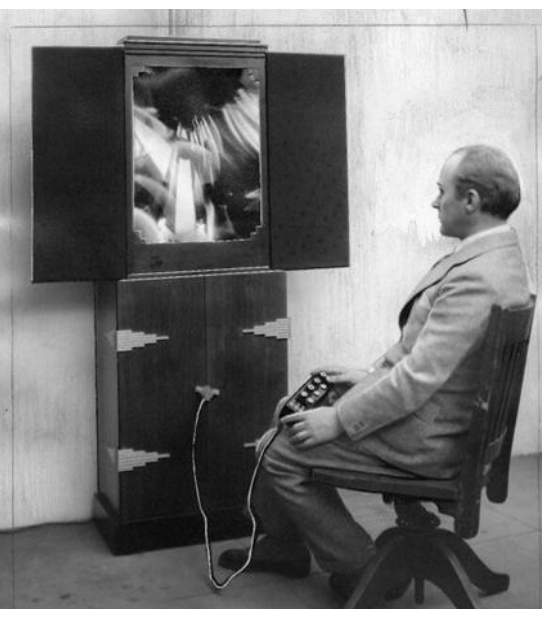
FIGURE 2 | The home version of the